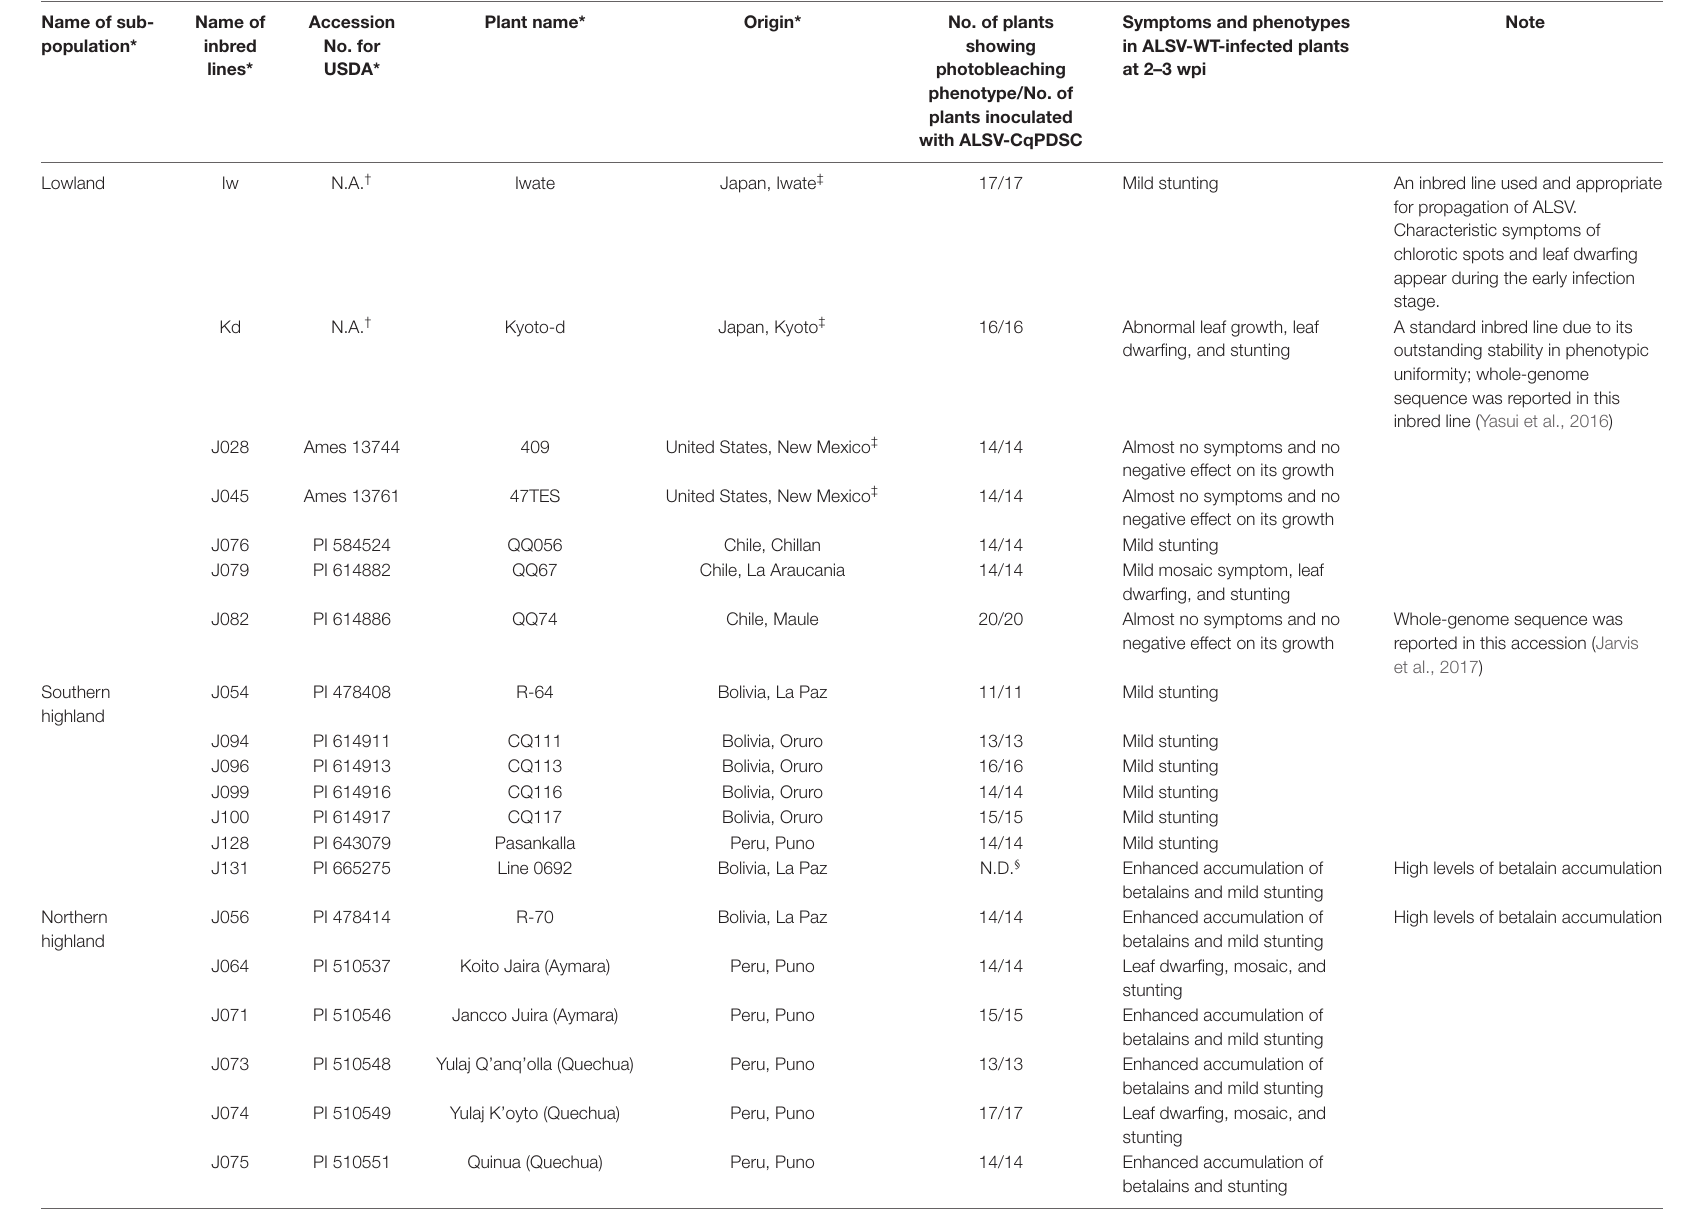
TABLE 1 | List of quinoa inbred lines used in this study and summary of the occurrence of the photobleaching phenotype in ALSV-CqPDSC-infected plants. Name of sub-